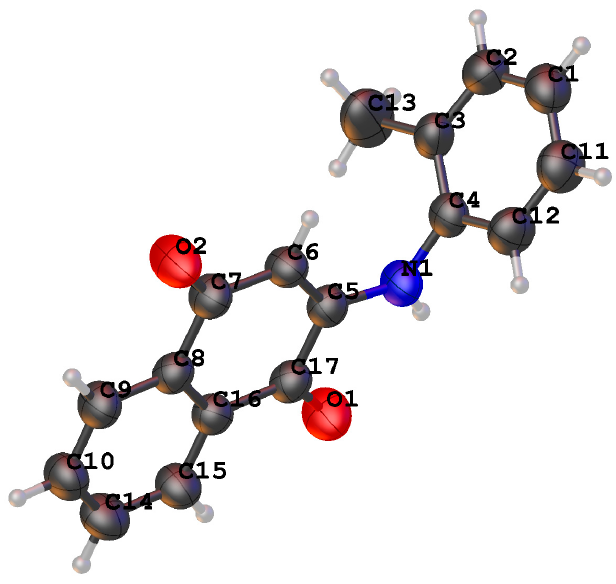
Figure 3. The crystal structure of compound 5a